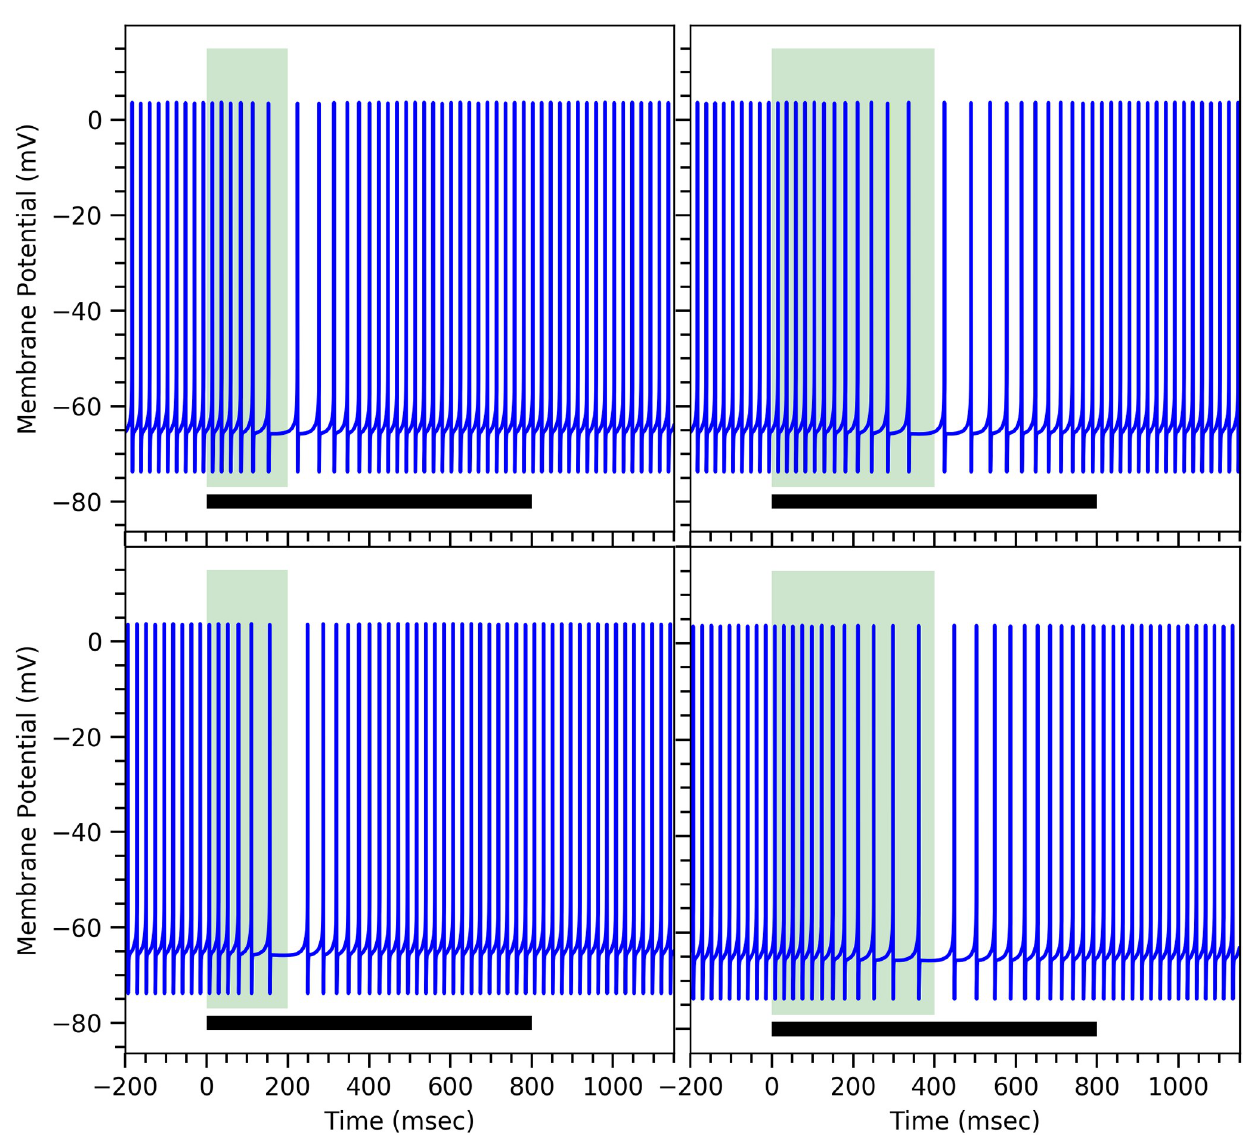
Fig 7. Different conditional responses of the Purkinje cell obtained from the mathematical models. Membrane potential of the Purkinje cell during conditional response for different ISIs = 200msec (left panels) and 400msec (right panels) for the minimal model (top panels) and the comprehensive model (bottom panels). The specific parameters values are given in Table 2, all others are the same as in (Fig 3). The width of the light green vertical bar corresponds to the duration of the ISI interval. The black horizontal bar at the bottom represents the conditional stimulus